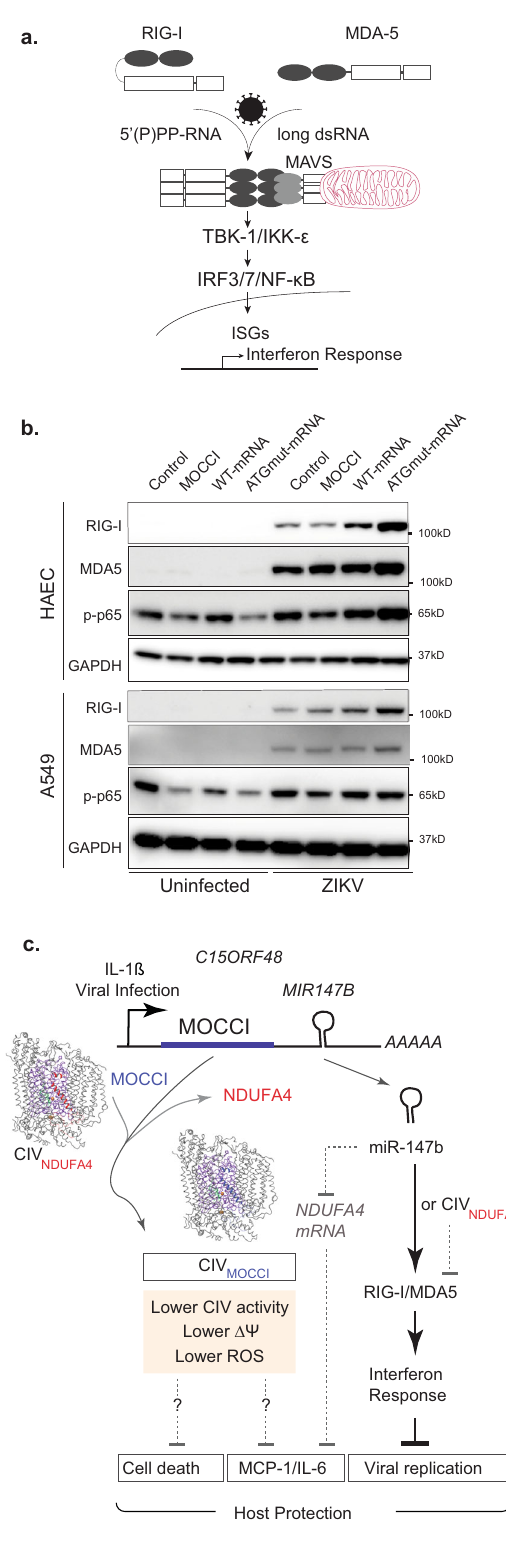
incorporated into CIV 39 , providing independent con fi rmation that MOCCI is a CIV protein. The switch from NDUFA4-to-MOCCI downregulates the activity of CIV. miR-147b-mediated NDUFA4 downregulation alone also reduces CIV activity, in line with previous fi ndings 15 .